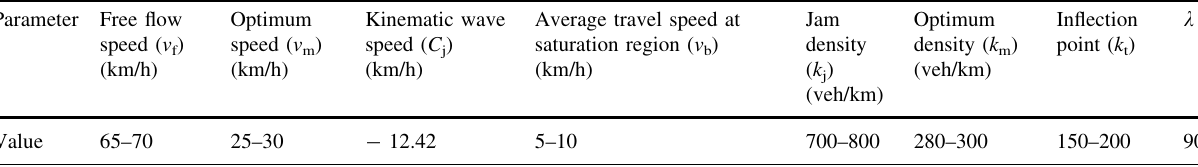
Table 3 Parameter values from empirical